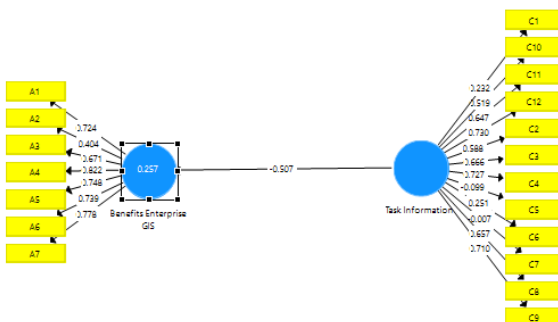
Figure 7. PLS SEM conceptual model for Task Information